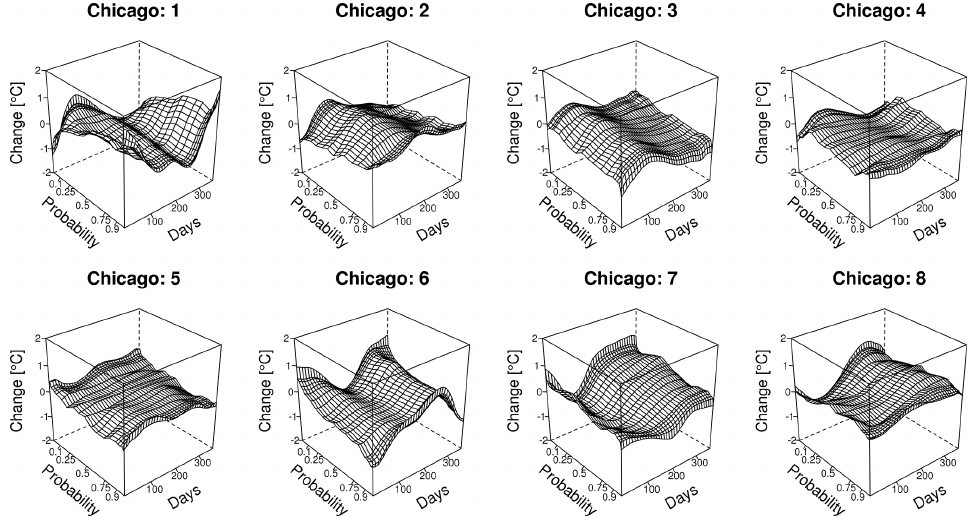
Figure 8. For 8 sets of 5 mutually exclusive simulations, panels show differences between quantile map estimates based on 5 simulations and the quantile map estimate using the full LENS 40-simulation ensemble (see Fig. 4) for Chicago.